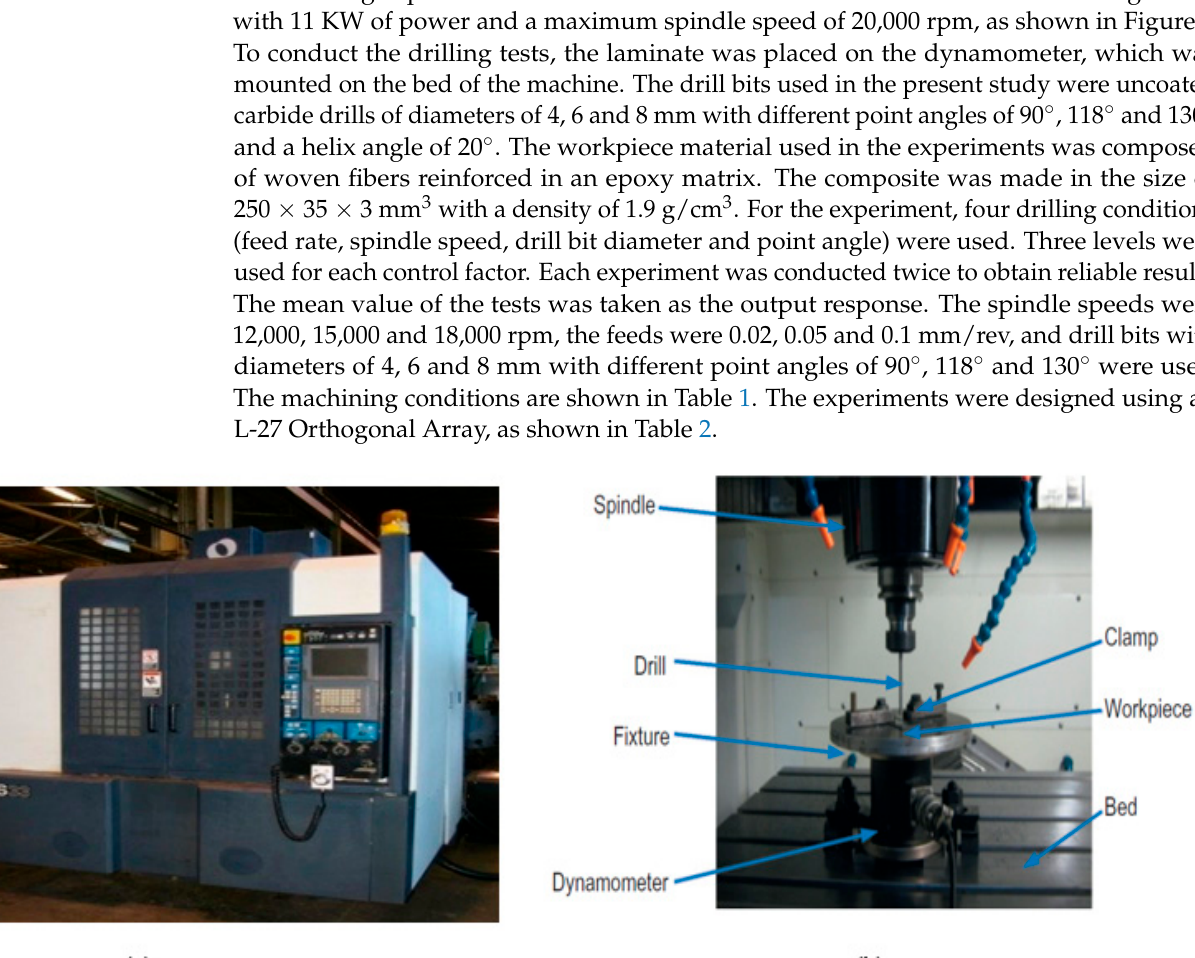
Table 1. Machining conditions.